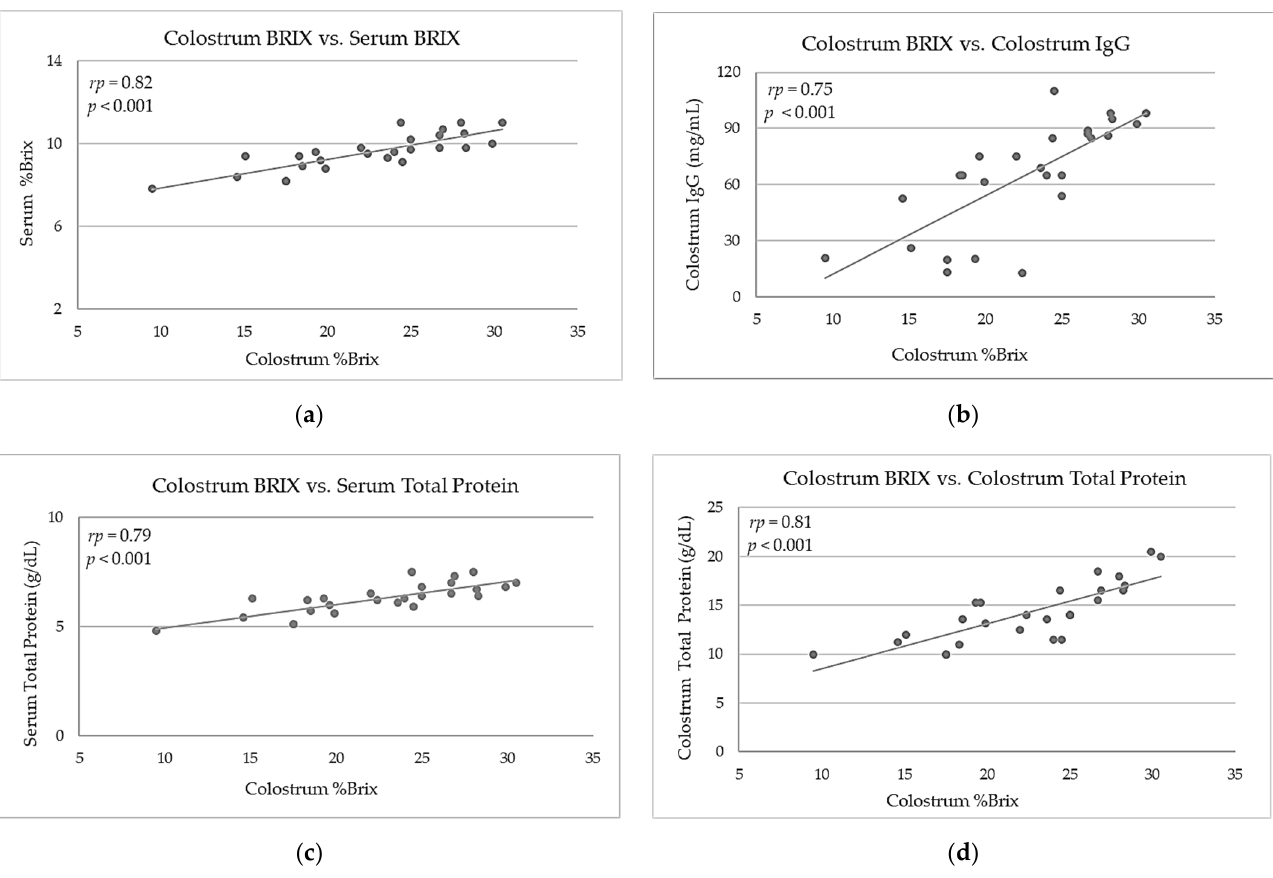
Figure 1. ( a ) Relationship between colostrum %Brix and calf serum %Brix (obtained 72 hours after birth) ( r p = 0.82, p < 0.001); ( b ) Correlation between colostrum %Brix and colostrum IgG (mg/mL) ( r p = 0.75, p < 0.001); ( c ) Correlation between colostrum %Brix and serum total protein (g/dL) ( r p = 0.79, p < 0.001); ( d ) Relationship between colostrum %Brix and colostrum total protein (g/dL) ( r p = 0.81, p < 0.001). r p is the Pearson’s coefficient of correlation.